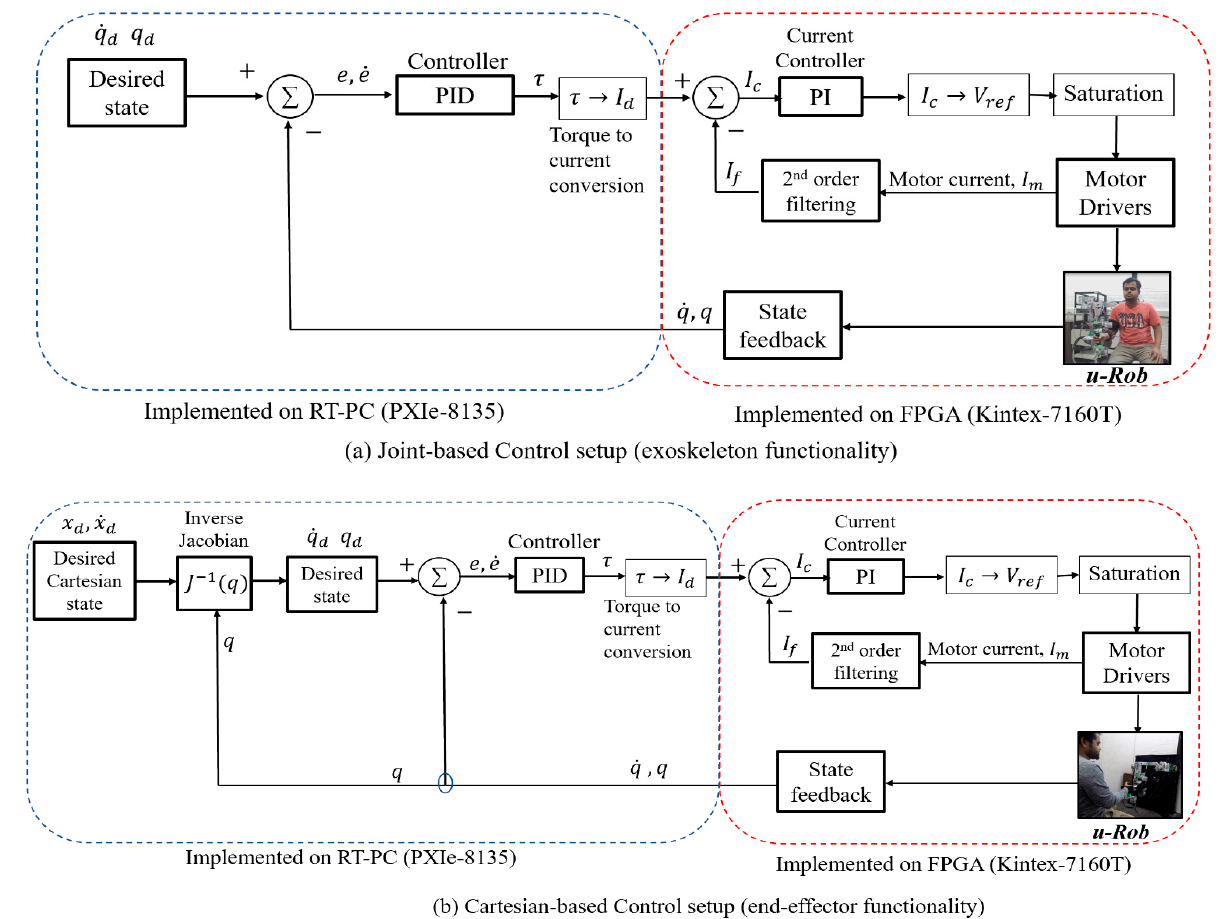
Micromachines 2021 , 12 , 870